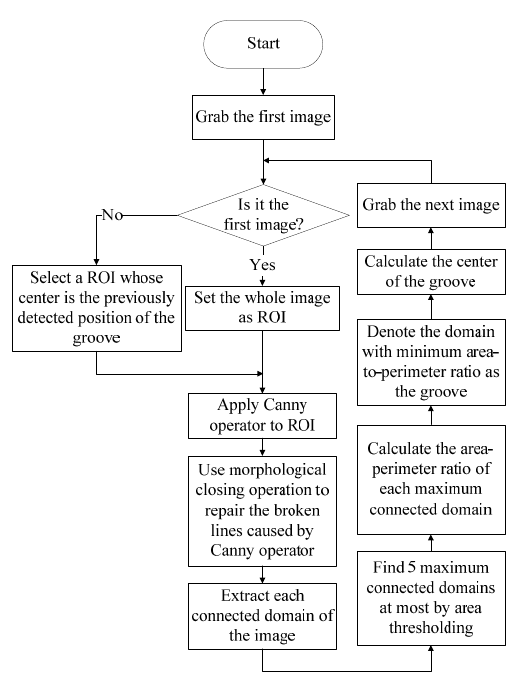
Figure 10. The image processing algorithm of narrow butt detection.